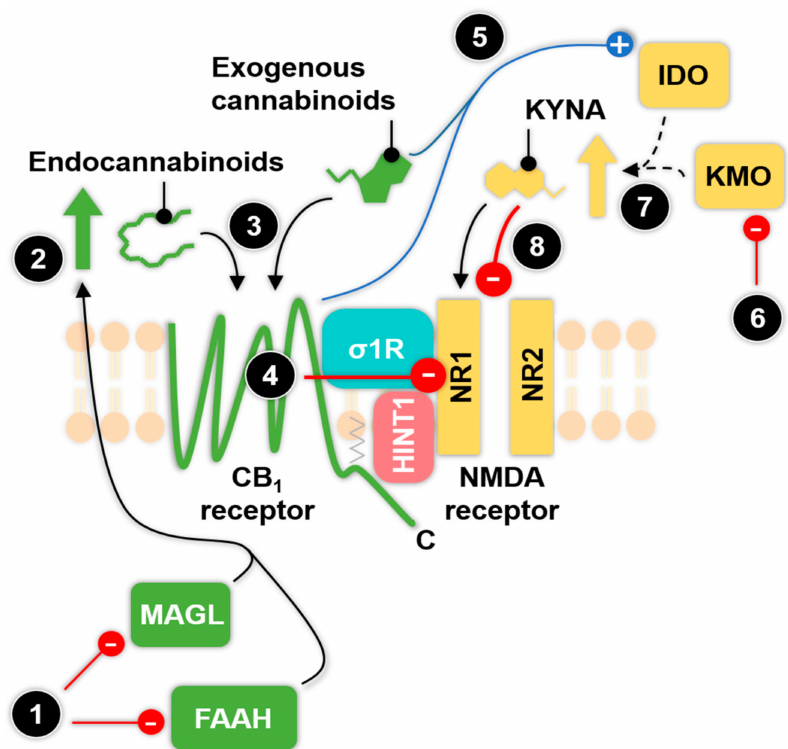
Figure 2. The type 1 cannabinoid receptor- N -methyl- D -aspartate (CB1-NMDA) receptor complex and potential pharmacological targets to reduce N -methyl- D -aspartate (NMDA) receptor hyperactivity, which is one of the main pathomechanism of migraine. The pharmacological inhibition (red arrow) of endocannabinoid metabolizing enzymes, monoacylglycerol lipase (MAGL) or fatty acid amide hydrolase (FAAH) (1) increases (upward green arrow) endocannabinoid levels (e.g., 2-arachidonoylglycerol (2-AG), anandamide (AEA)) (2) [113], thus enhancing the agonist-mediated type 1 cannabinoid receptor (CB1) receptor activity (3) (in this step the black